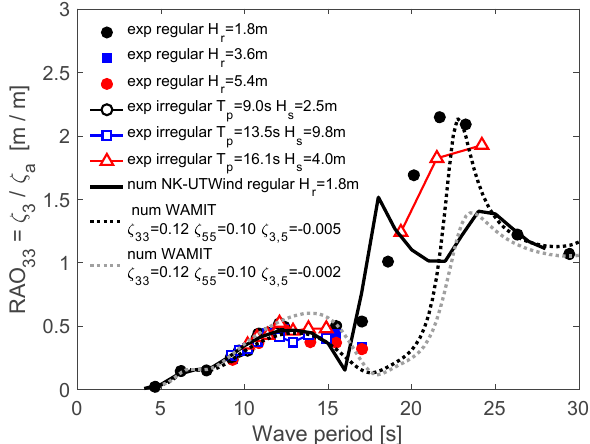
Figure 11. RAO heave motion result comparisons between the experiment and numerical calculations.